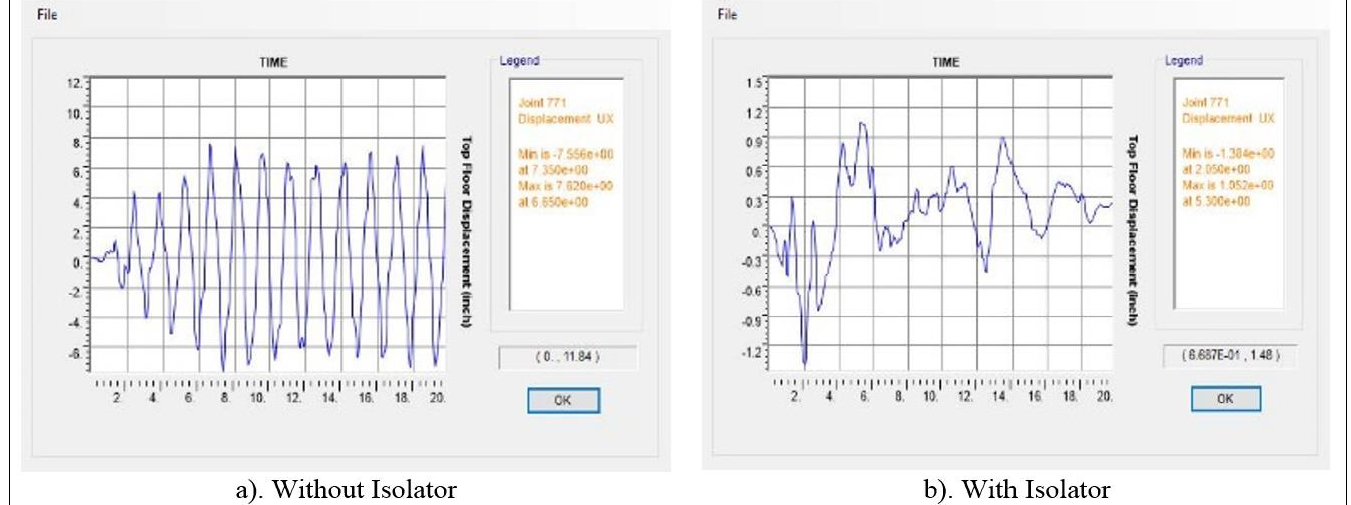
Figure 8: Top floor displacement vs time curve (20 sec).